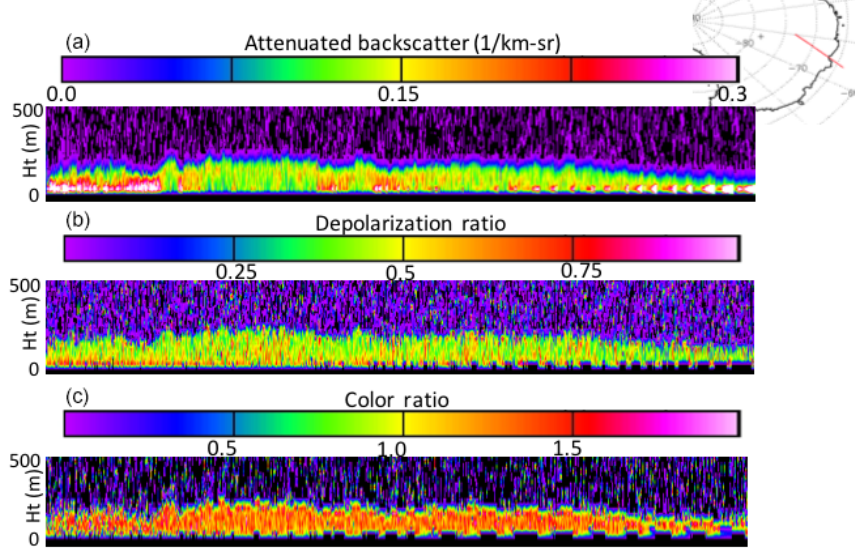
Figure 1. A typical Antarctic blowing snow layer as measured by CALIPSO on 28 May 2015 at 17:08:41–17:11:33UTC. Displayed (a–b) are the 532nm calibrated attenuated backscatter, the depolarization ratio at 532nm and the color ratio (1064nm /